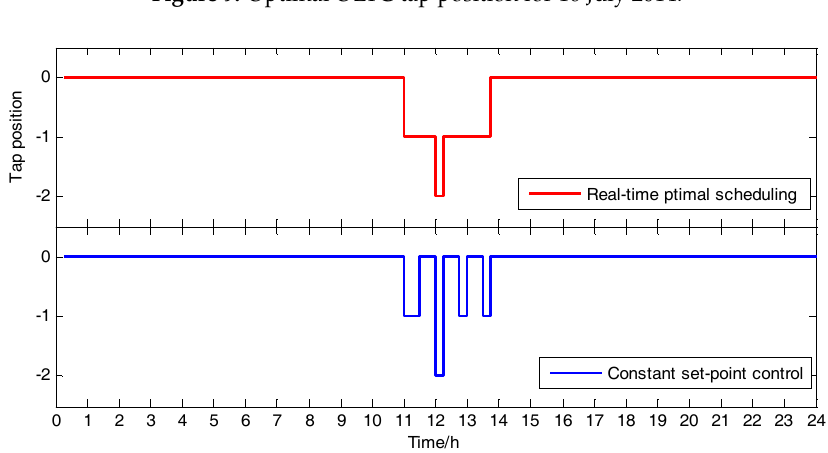
Figure 10. Comparison of the proposed scheme and constant set-point control (CSC).